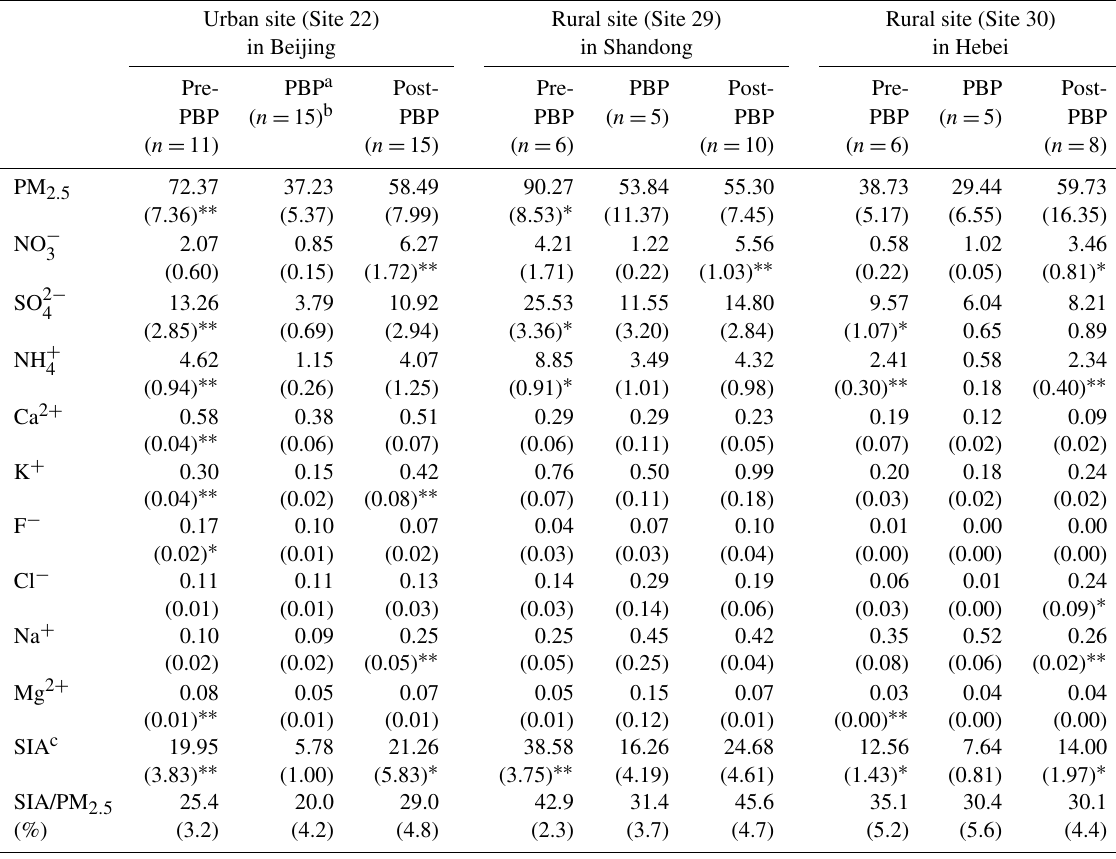
Table 1. Mean (standard error) ambient concentrations of PM 2 . 5 and associated ionic components at the urban and rural sites. PBP denotes the Parade Blue